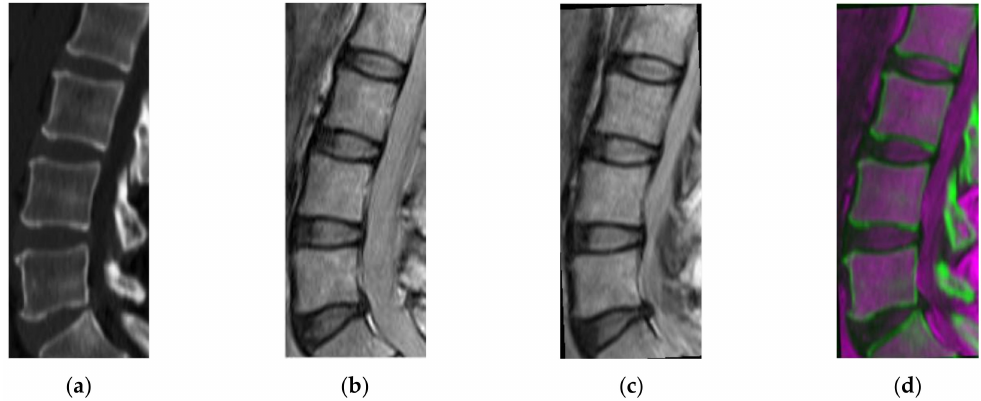
Figure 2. ( a ) Initial computed tomography (CT) image, ( b ) initial magnetic resonance imaging (MRI) image, ( c ) register MRI, ( d ) fusion CT and